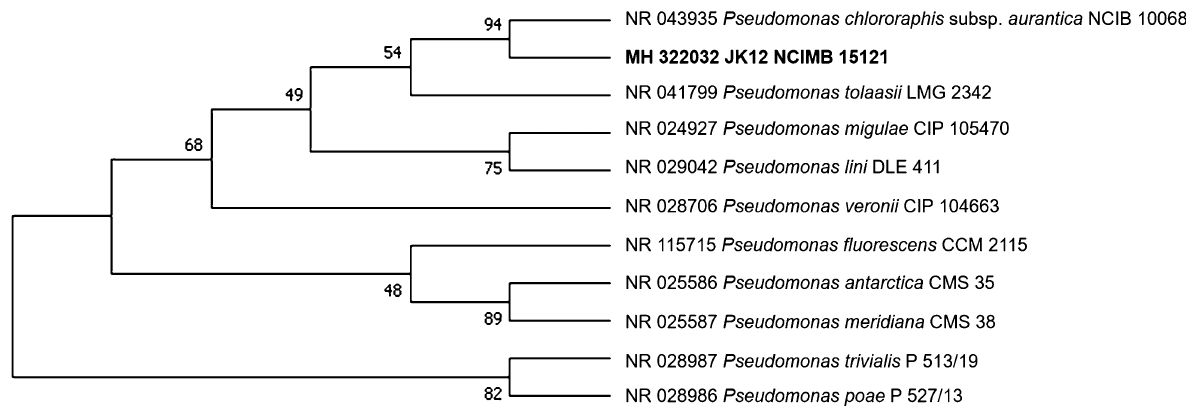
Fig. 3 Phylogenetic tree of JK12 based on 16 s rRNA sequences obtained from